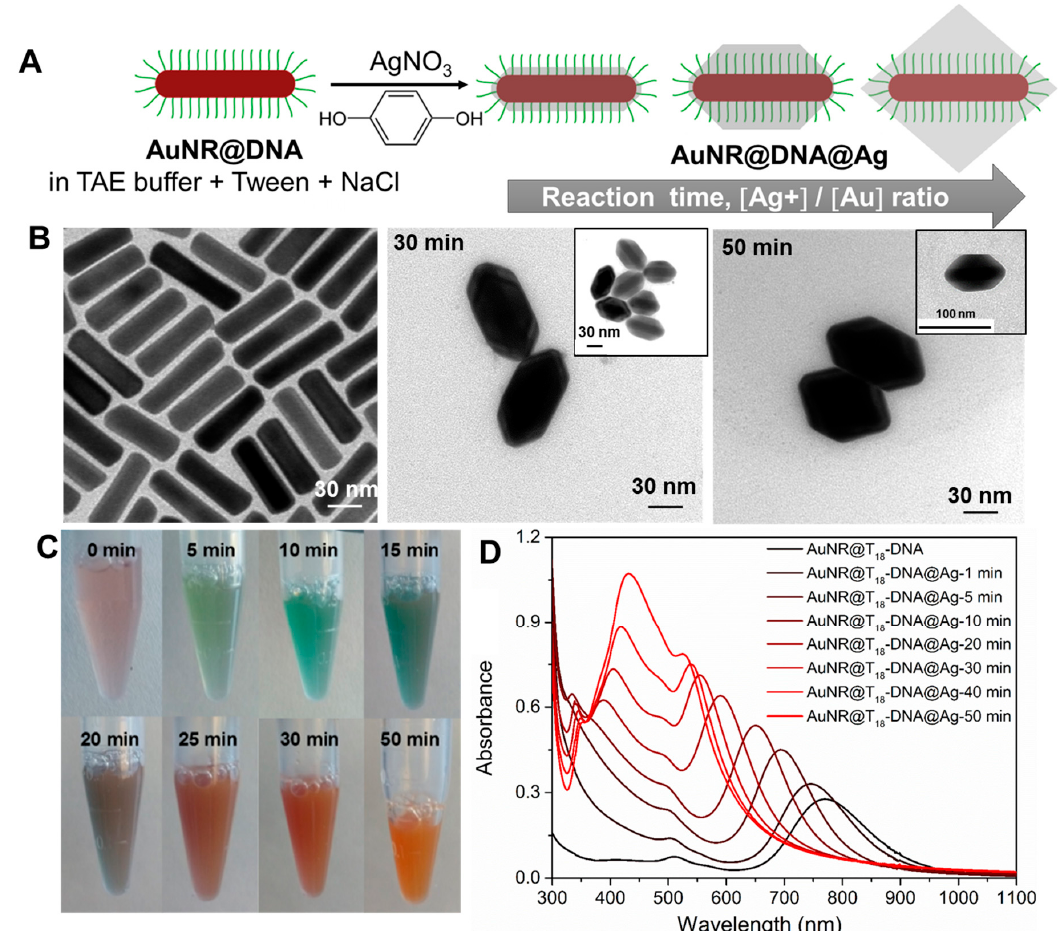
Figure 1. ( A ) Sketch showing the gradual evolution of AuNRs@DNA into directional building blocks by epitaxial Ag overgrowth. By controlling the reaction time and Ag + /Au ratio, the resulting AuNRs@DNA@Ag will be: nondirectional (truncated octahedra with all DNA strands available for hybridization, left); directional (truncated octahedra with the DNA strands at the tip region available for hybridization, center); or partially directional, but colloidally unstable (nontruncated octahedra with most DNA strands inactivated for hybridization, right). ( B ) TEM micrographs depicting the starting AuNRs@T 18 -DNA (0 min, left panel) and the resulting AuNRs@T 18 -DNA@Ag at an intermediate reaction time (30 min) and after completion of the reaction (50 min). ( C ) Photographs illustrating the color changes of the AuNRs@T 18 -DNA dispersion (0 min) at the indicated reaction times. ( D ) Corresponding UV–Vis–NIR spectra during Ag overgrowth.